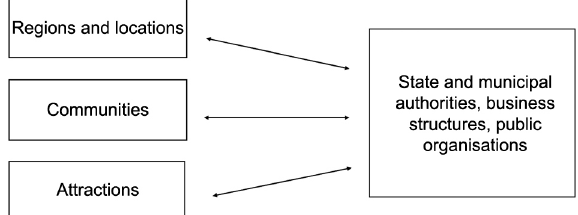
Fig. 3. The system of interaction of entities in the regulation of tourism for people with